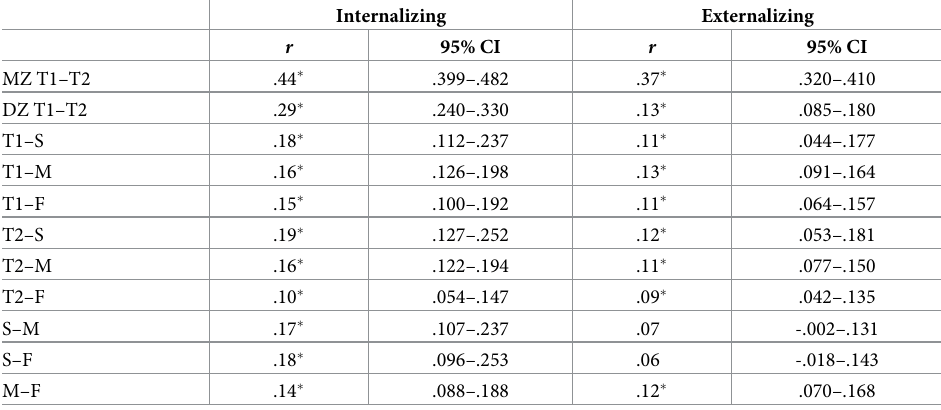
The correlations among all family members are shown in Table 3. For INT, all kin correlations were significant. Correlations between MZ twins were clearly higher than correlations between the MZ correlations, suggesting shared environmental influences (ct 2 and/or cs 2 ). All twin– sibling and parent–child correlations were lower than the DZ twin correlation, suggesting twin-specific environmental influences (ct 2 ). The correlation between parents indicated weak Table 3. Kin correlations.